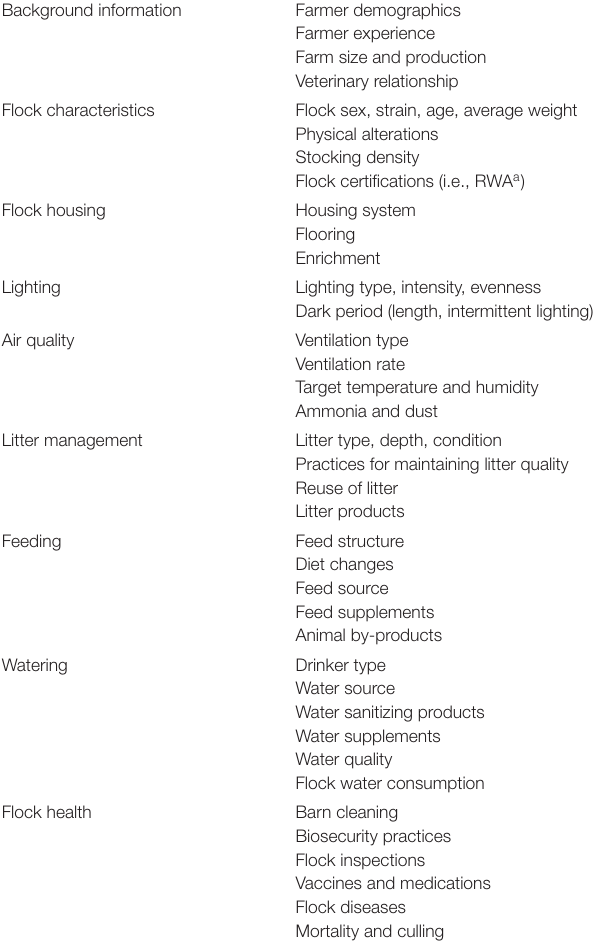
TABLE 1 | A summary of the housing and management information on Canadian turkey flocks obtained from the survey